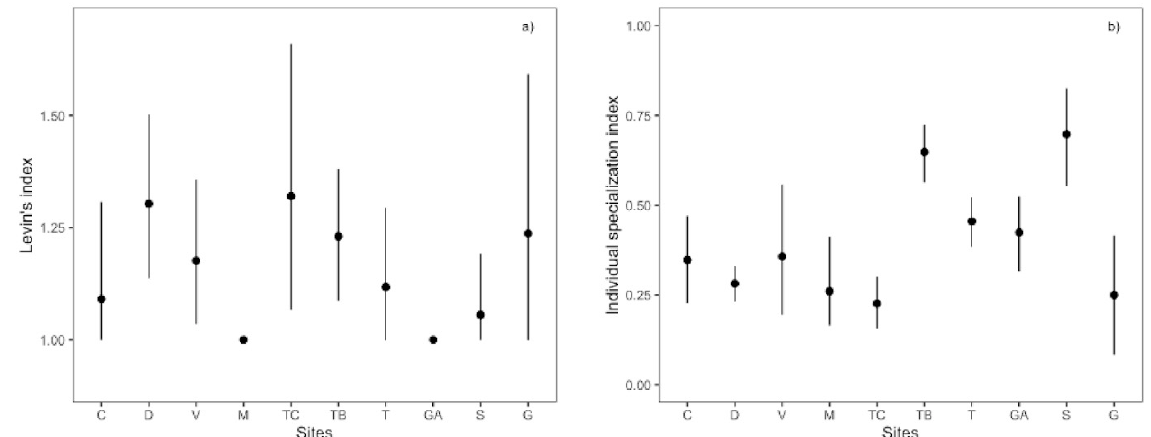
Figure 4. Population and individual niche breadth of the pikeperch Sander lucioperca populations in Portuguese basins: ( a ) Levin’s index) and ( b ) individual specialization index. Error bars represent bootstrapped 95% confidence intervals for each index. Sites are ordered by decreasing latitude. Population acronyms according to Figure 1.